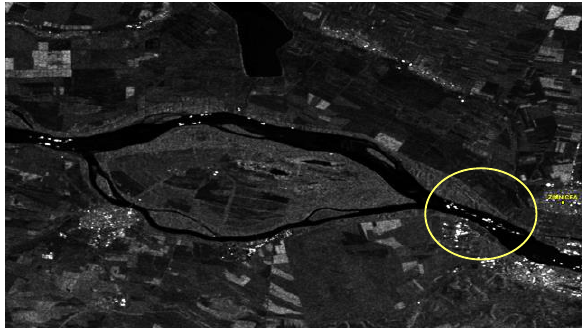
Figure 3. Zimnicea Harbour – 27.07.2015 - Sentinel-1A